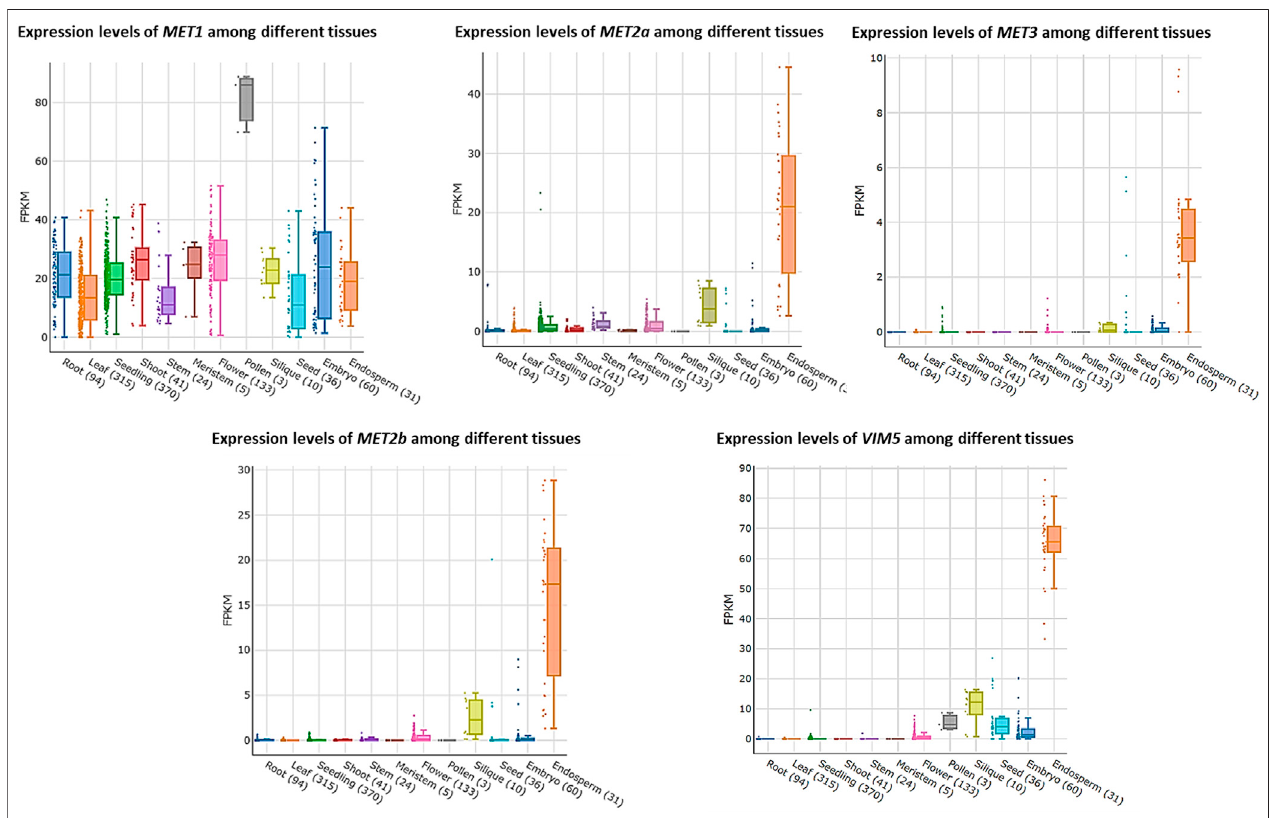
FIGURE 1 | Expression levels of MET1 , MET2a , MET2b , MET3 and VIM5 among different